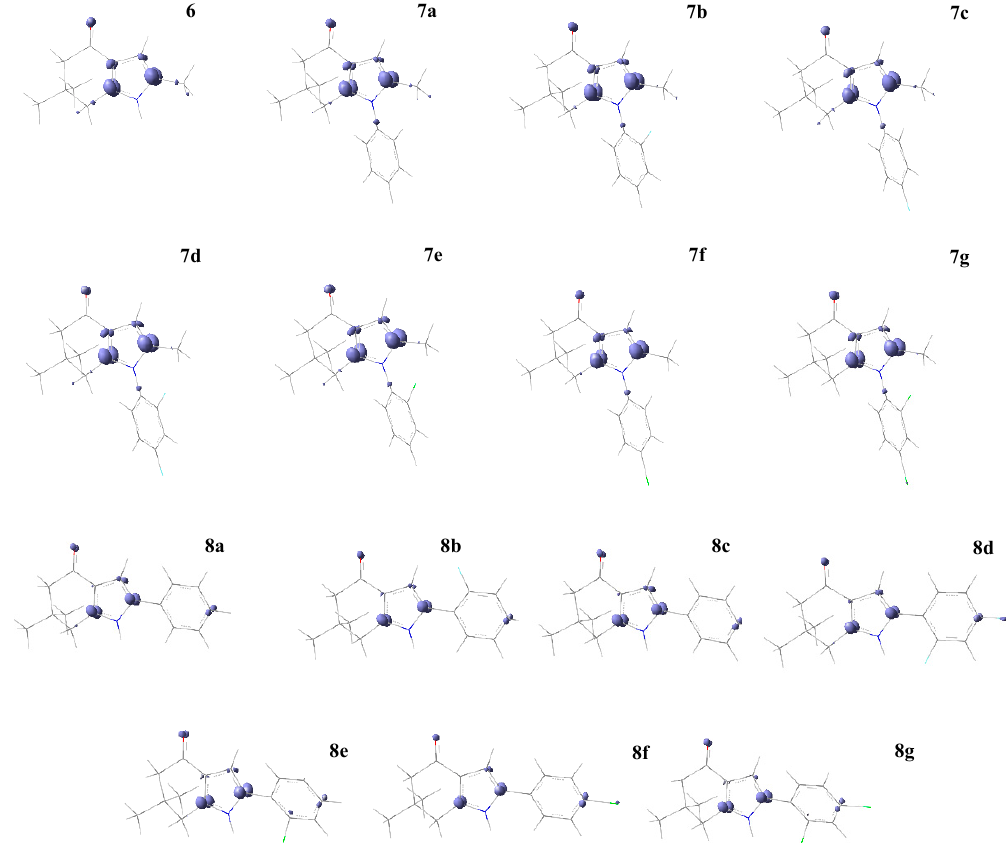
Figure 2. Fukui function isosurface plots for an electrophilic attack f − ( r ) of series I and II of compounds 6 , 7a – g , and 8a – g . In purple (positive values) are the favorable sites for an electrophilic attack; cutting value 0.01 a.u.